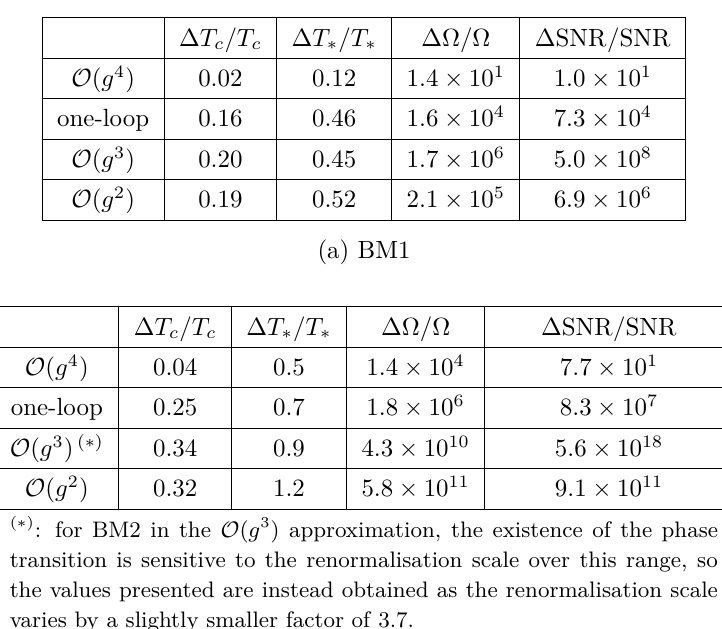
Table 1. Summary of theoretical uncertainties due to residual renormalisation scale dependence for the four different approximations. In each case ∆ X/X ≡ (max( X ) − min( X )) / min( X ) , where the set X consists of the values obtained as the renormalisation scale varies by a factor of 4. Here Ω refers to the gravitational wave peak amplitude and SNR to the LISA signal-to-noise ratio for a 3 year mission, computed using PTPlot